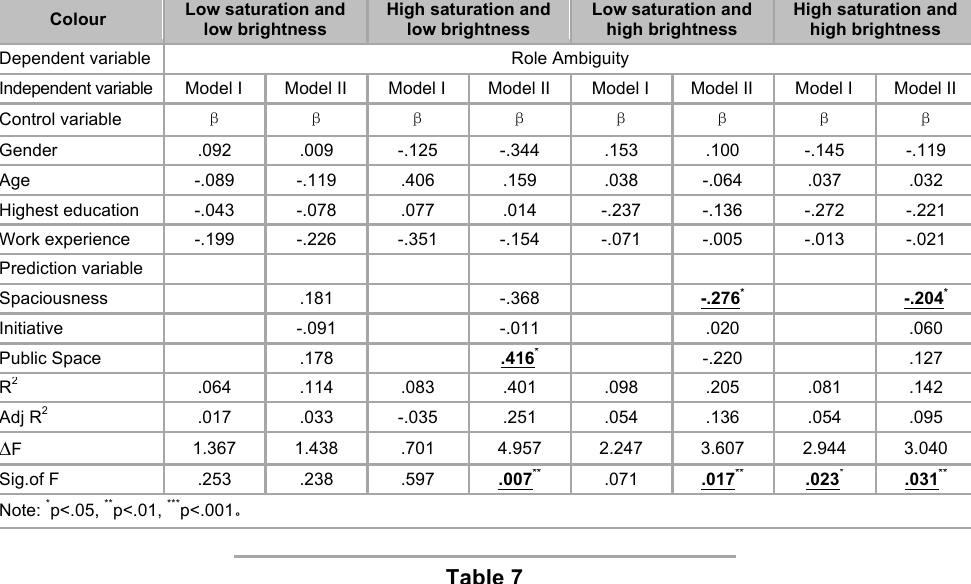
Regression analysis of the moderating effects of Colour on the relations between Office Space and Work Stress (Role Ambiguity)